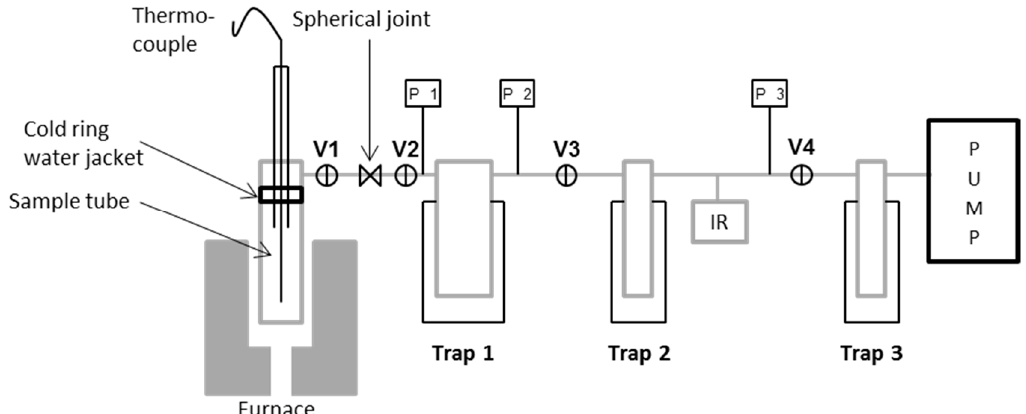
Figure 1. Simplified block diagram of single line thermal volatilisation analyser (TVA) setup used for vacuum heat treatment of glass fibre.